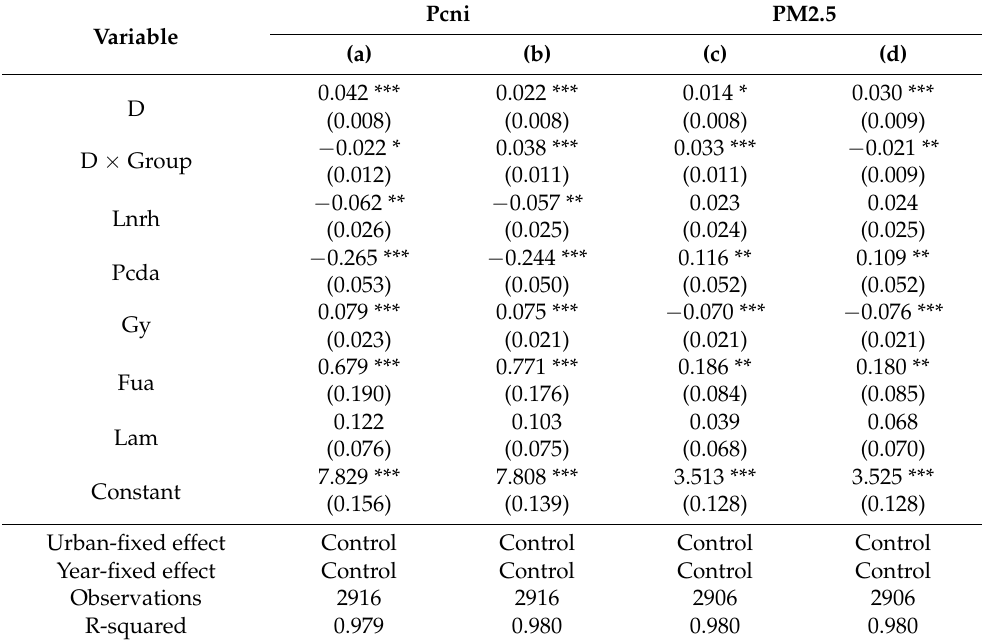
Table 5. Heterogeneity